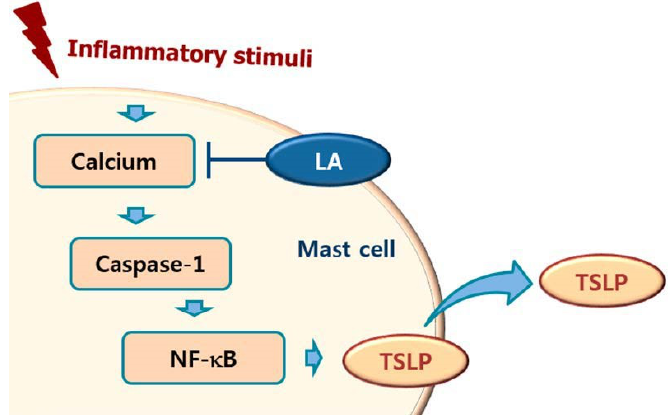
Figure 7. Schematic diagram of proposed regulation of TSLP by LA. Upon receipt of inflammatory stimuli, the level of intracellular calcium increased, and increased intracellular calcium resulted in the activation of caspase-1, and then the activated caspase-1 induced NF- κ B activation in mast cells. Finally, the activated NF- κ B induced the production of TSLP from mast cells. In this study, LA inhibited the production of TSLP by down-regulating the intracellular calcium/caspase-1/NF- κ B signal cascade in mast cells.